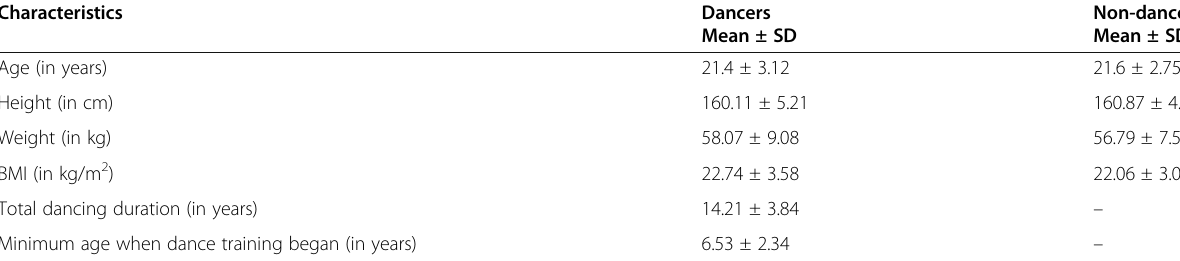
Table 1 Demographic characteristics of Bharatanatyam dancers and non-dancers Characteristics